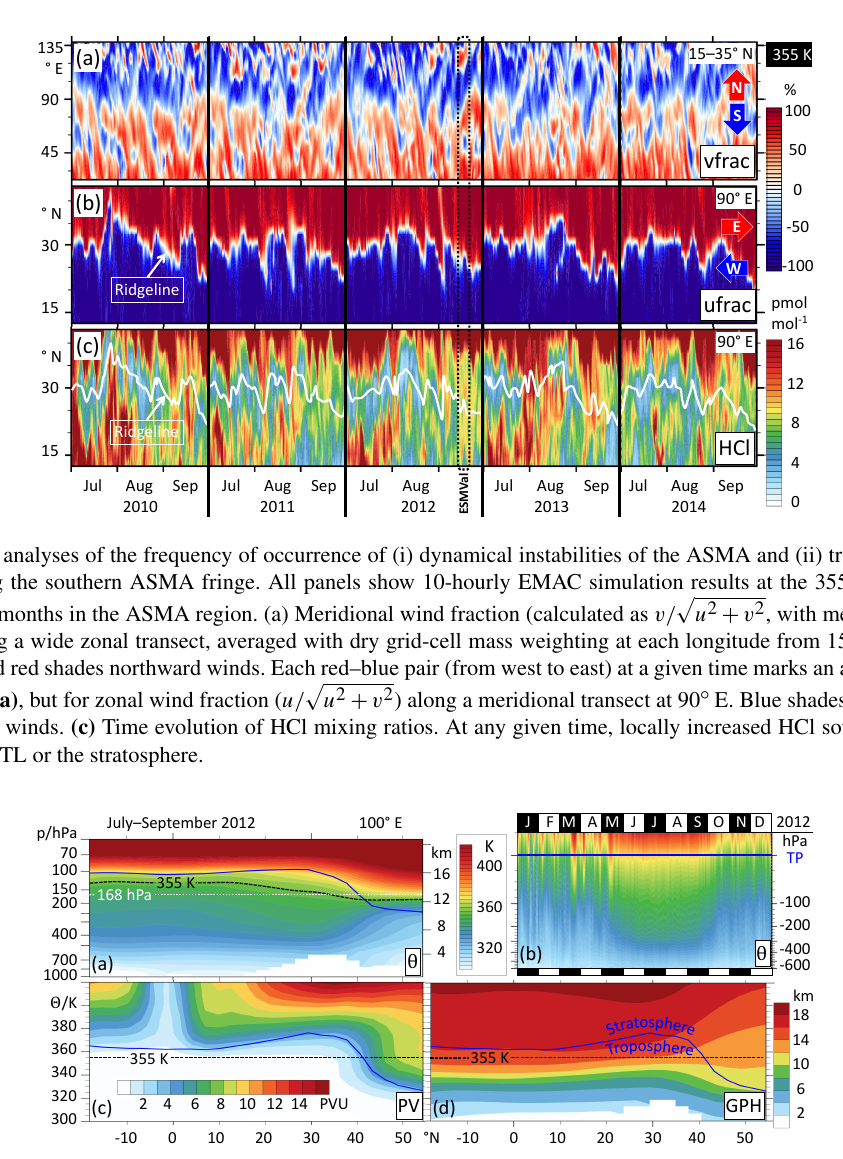
Figure 4. EMAC-simulated relations between different parameters of the stratification of the atmosphere in the Tibetan region. Potential temperature ( θ ), potential vorticity (PV) and geopotential height (GPH) in vertical cross sections at 100 ◦ E. The levels of θ = 355K and p = 168hPa are chosen for horizontal slices in the paper. Panels (a) , (c) , (d) show time averages for the monsoon months of 2012. Panel (b) shows the evolution of θ profiles (grid-cell dry air mass weighted averages from 15–35 ◦ N, 65–100 ◦ E) throughout 2012 in pressure coordinates relative to the tropopause (TP). Note the steeply inclining TP over the Tibetan plateau, which marks the transition from the extratropics (dominated by baroclinic wave activity and downward stratospheric circulation) to the tropics (dominated by radiative-convective balance and upward stratospheric circulation). Heating of the Tibetan plateau in summer brings UT isentropes closer to the surface (panel b ), leading to intersections between the inclined TP and a range of isentropes (panel a